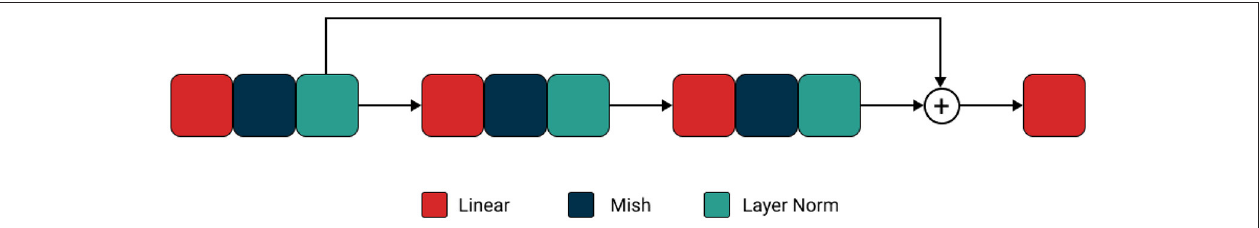
FIGURE 1 | Neural network of ImmuneNet